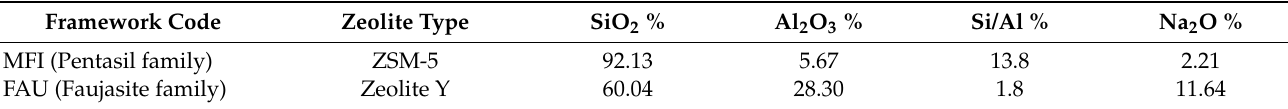
Table 2. Chemical composition of ZSM-5 and ZY (Data adapted from [40]). Framework Code